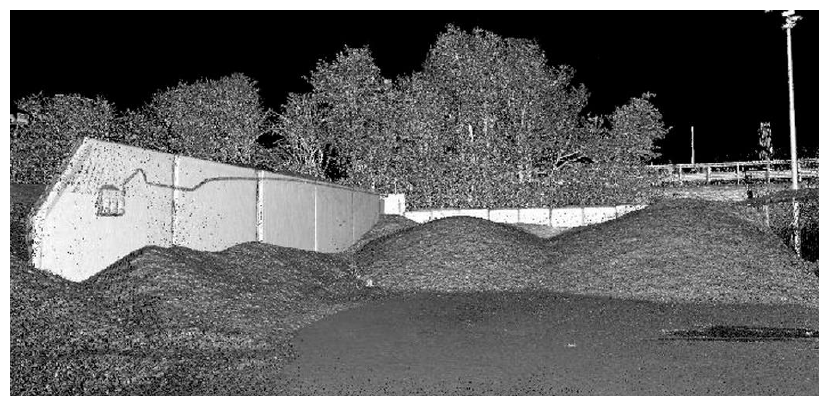
Figure 3. Laser scanner point cloud of the waste piles.